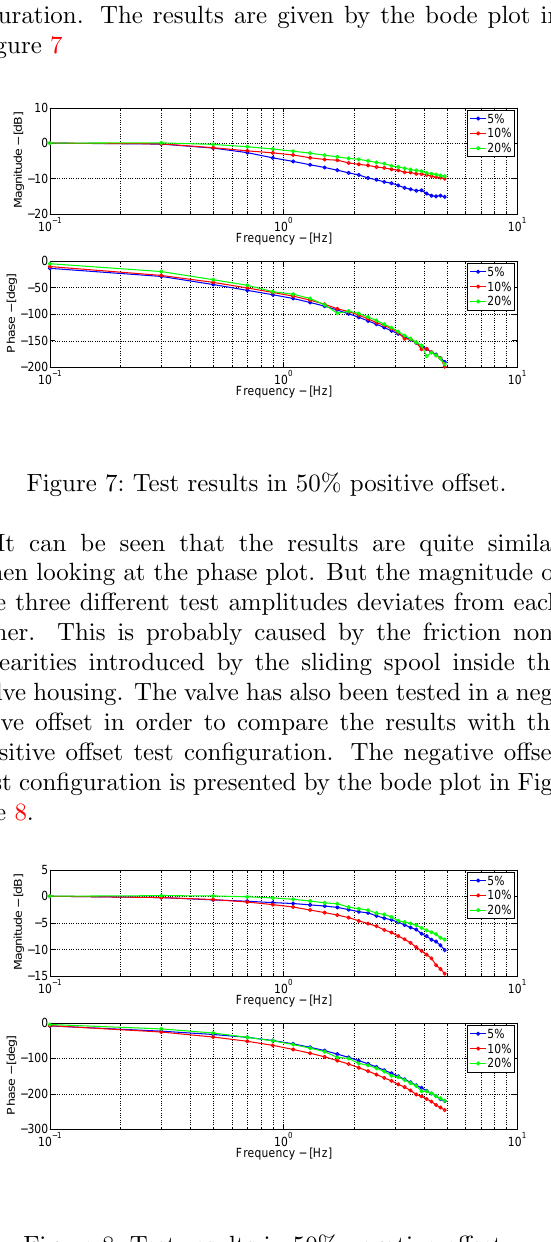
Figure 8: Test results in 50% negative